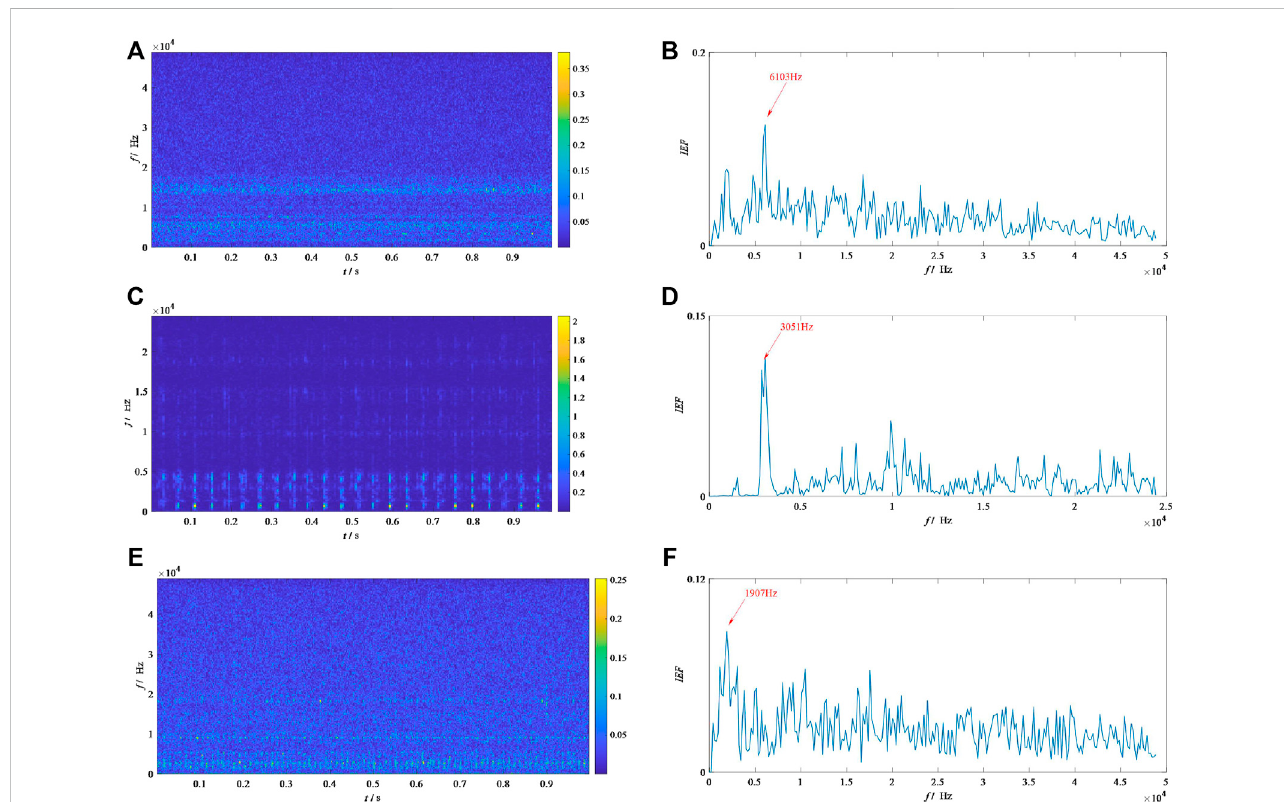
FIGURE 6 ResultsofIEFIforsignalsfromMFPT: (A) and (B) correspondtotheSTFTandIEFIofthehealthybearing, (C) and (D) correspondtotheSTFTandIEFIofthe inner race fault bearing, and (E) and (F) correspond to the STFT and IEFI of the outer race fault